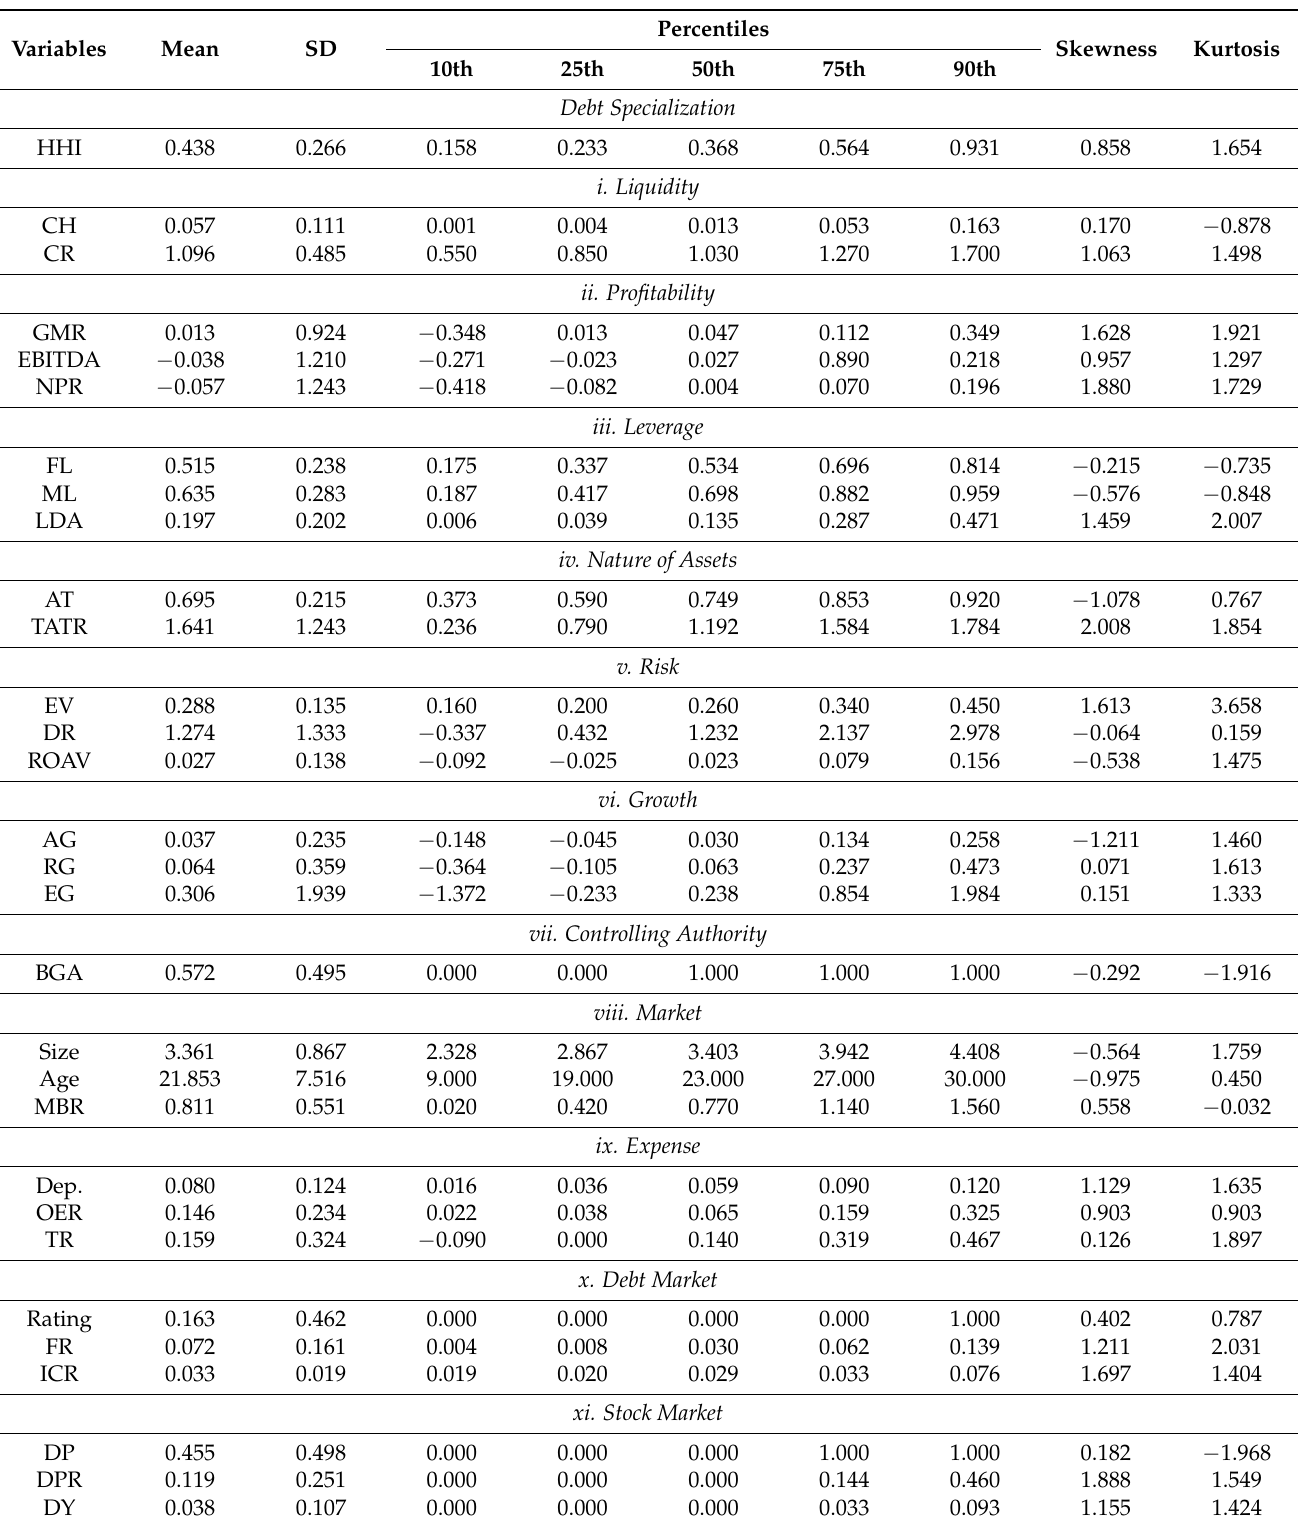
Table 3. Summary statistics for Pakistani listed